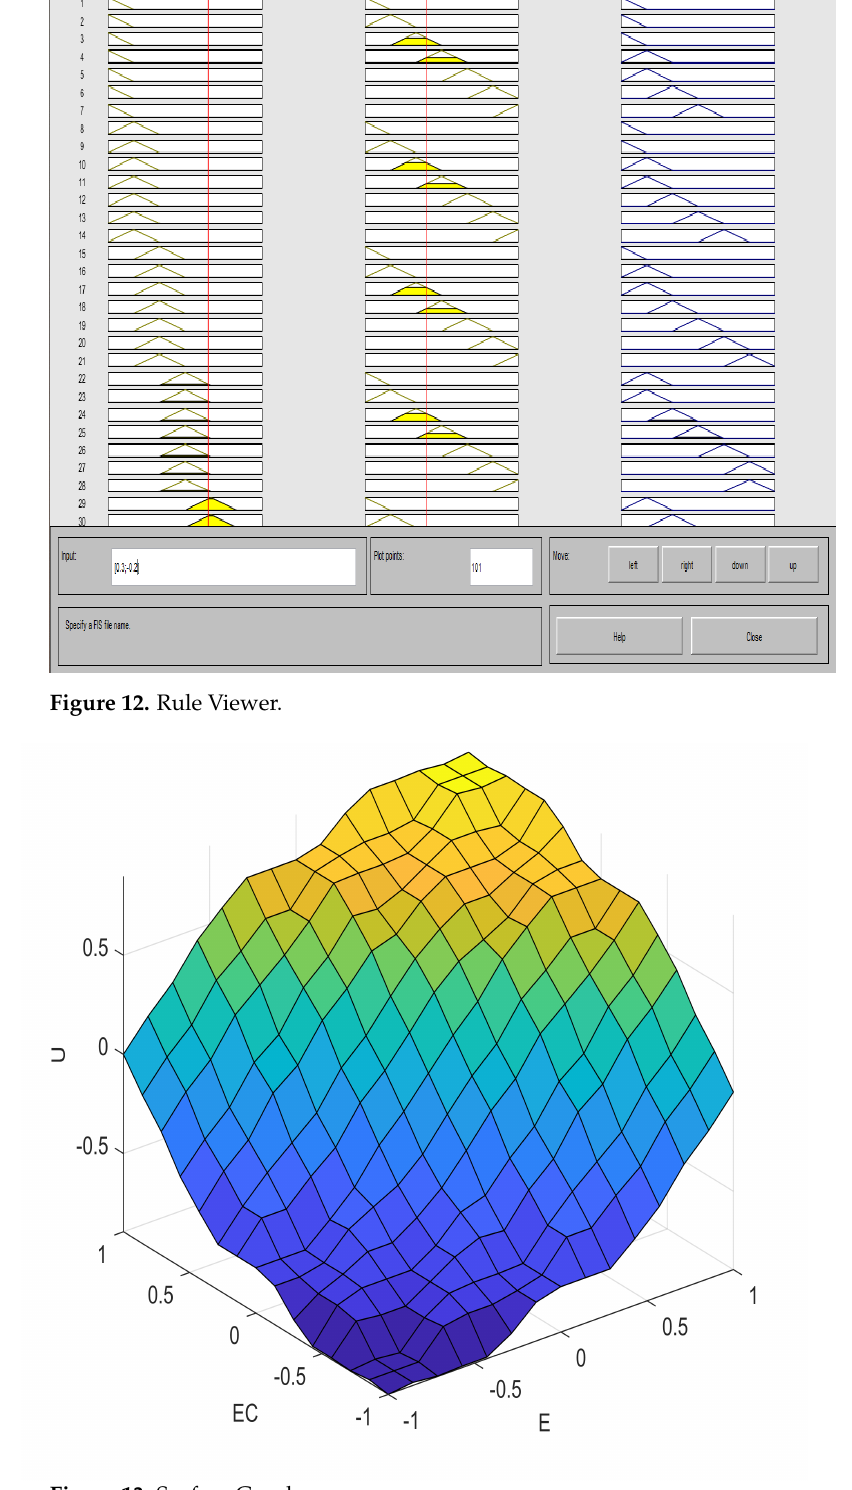
Figure 13. Surface